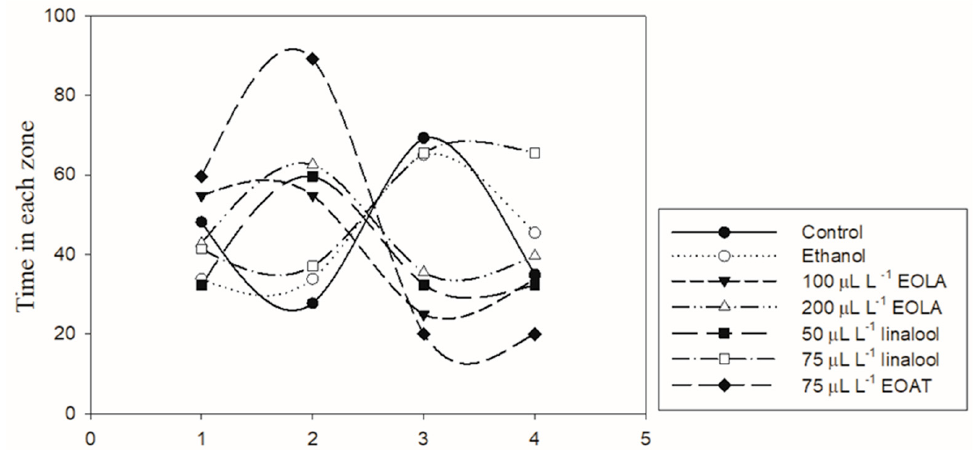
the aquarium zones between the different treatments ( p < 0.05; by one ‐ way ANOVA followed by aquarium zones between the different treatments ( p < 0.05; by one-way ANOVA followed by Tukey’s Tukey’s or Kruskal–Wallis tests; n = 5 per group). or Kruskal–Wallis tests; n = 5 per group).